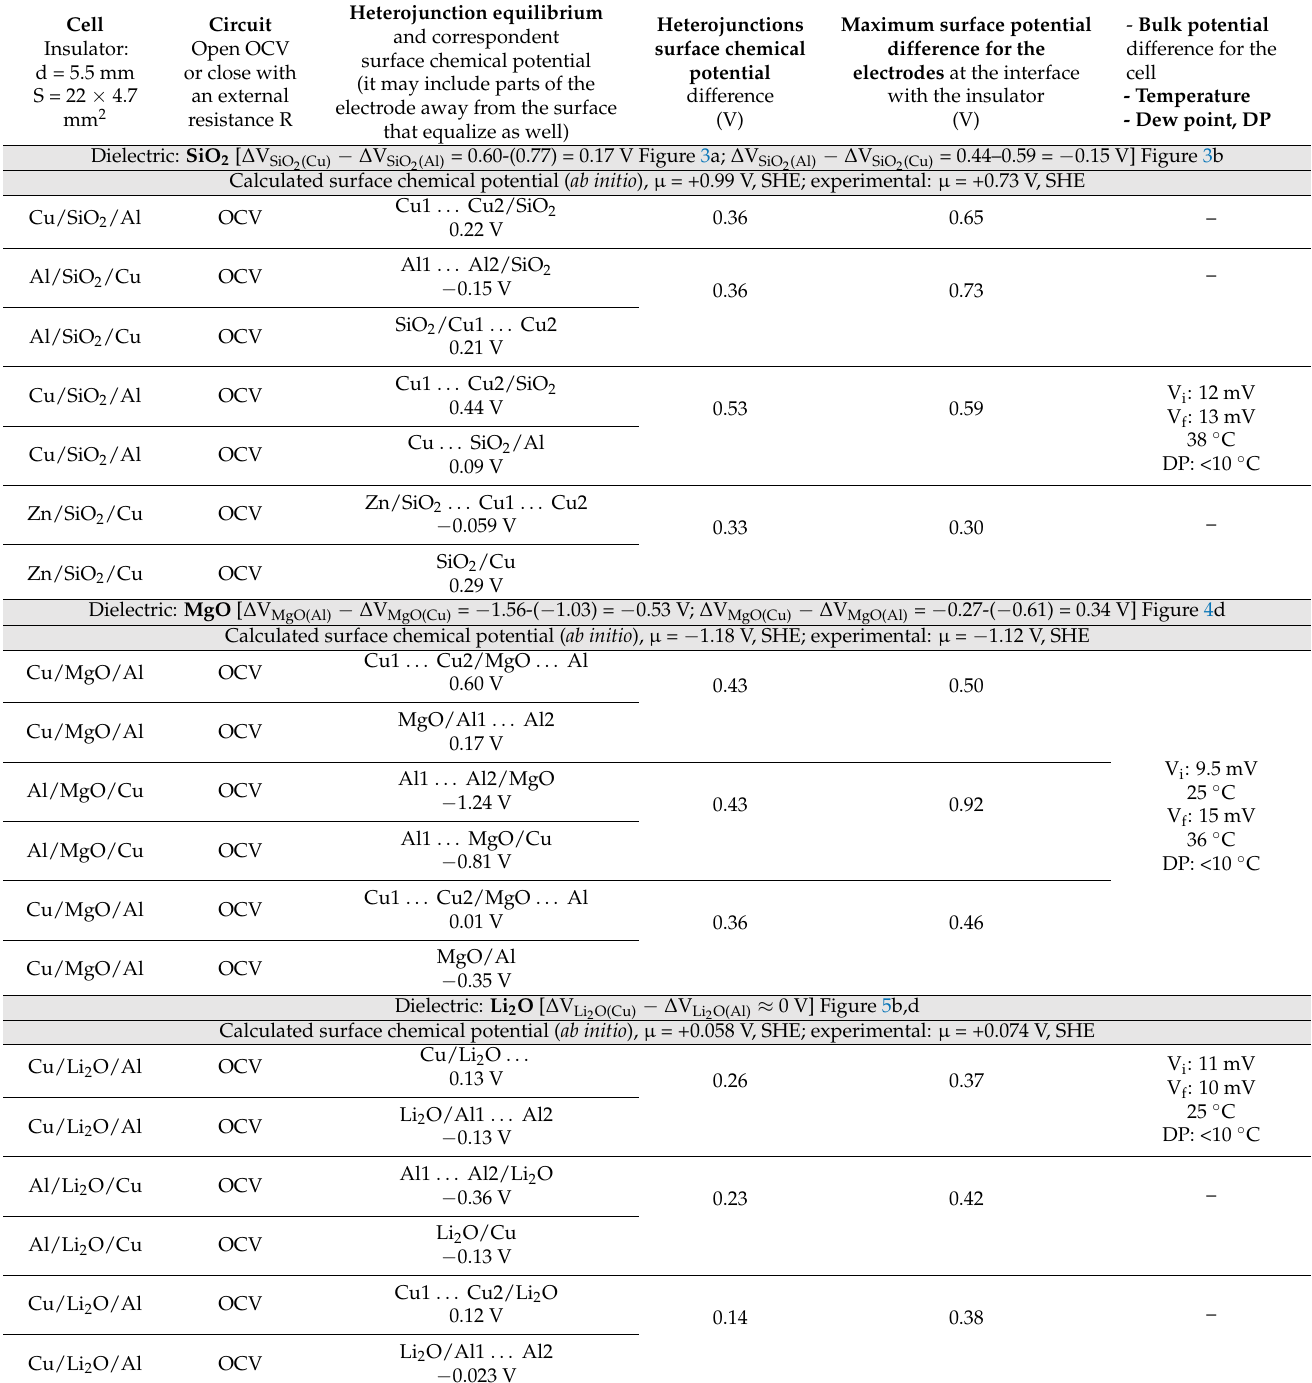
Table 2. Physical information is extracted from AFM, SKP, electrochemical analysis, and ab initio simulations for the cell when the insulator is a dielectric oxide or a solid electrolyte. Note : calcu- lated: µ Cu = +0.14 V, SHE [31]; experimental: µ Cu = +0.12 V, SHE; calculated: µ Al = +0.25 [31] to +0.63 V, SHE; experimental: µ Al = − 1.01 V, SHE; calculated µ Zn = − 0.95 V, SHE [31]; experimental: µ Zn = − 0.42 V, SHE.